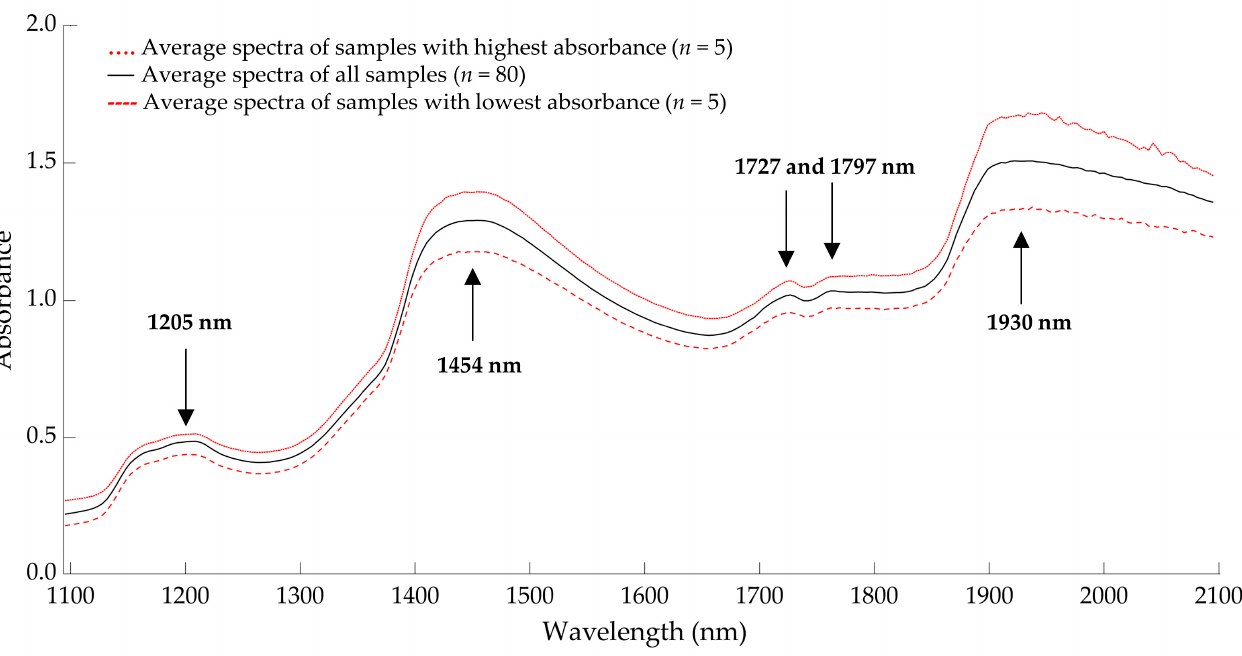
Figure 3. Average spectral data of living mealworm larvae from samples with the lowest ( n = 5) and highest ( n = 5) absorbance compared to all samples ( n = 80).